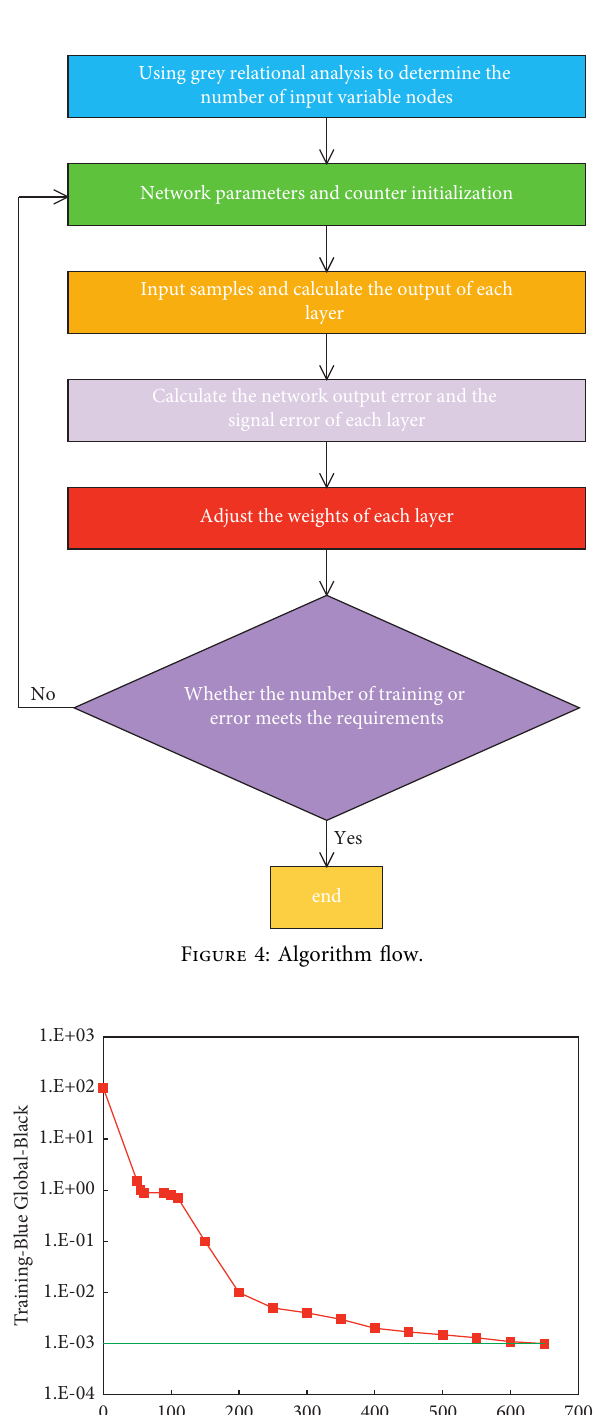
Figure 5: Network training.